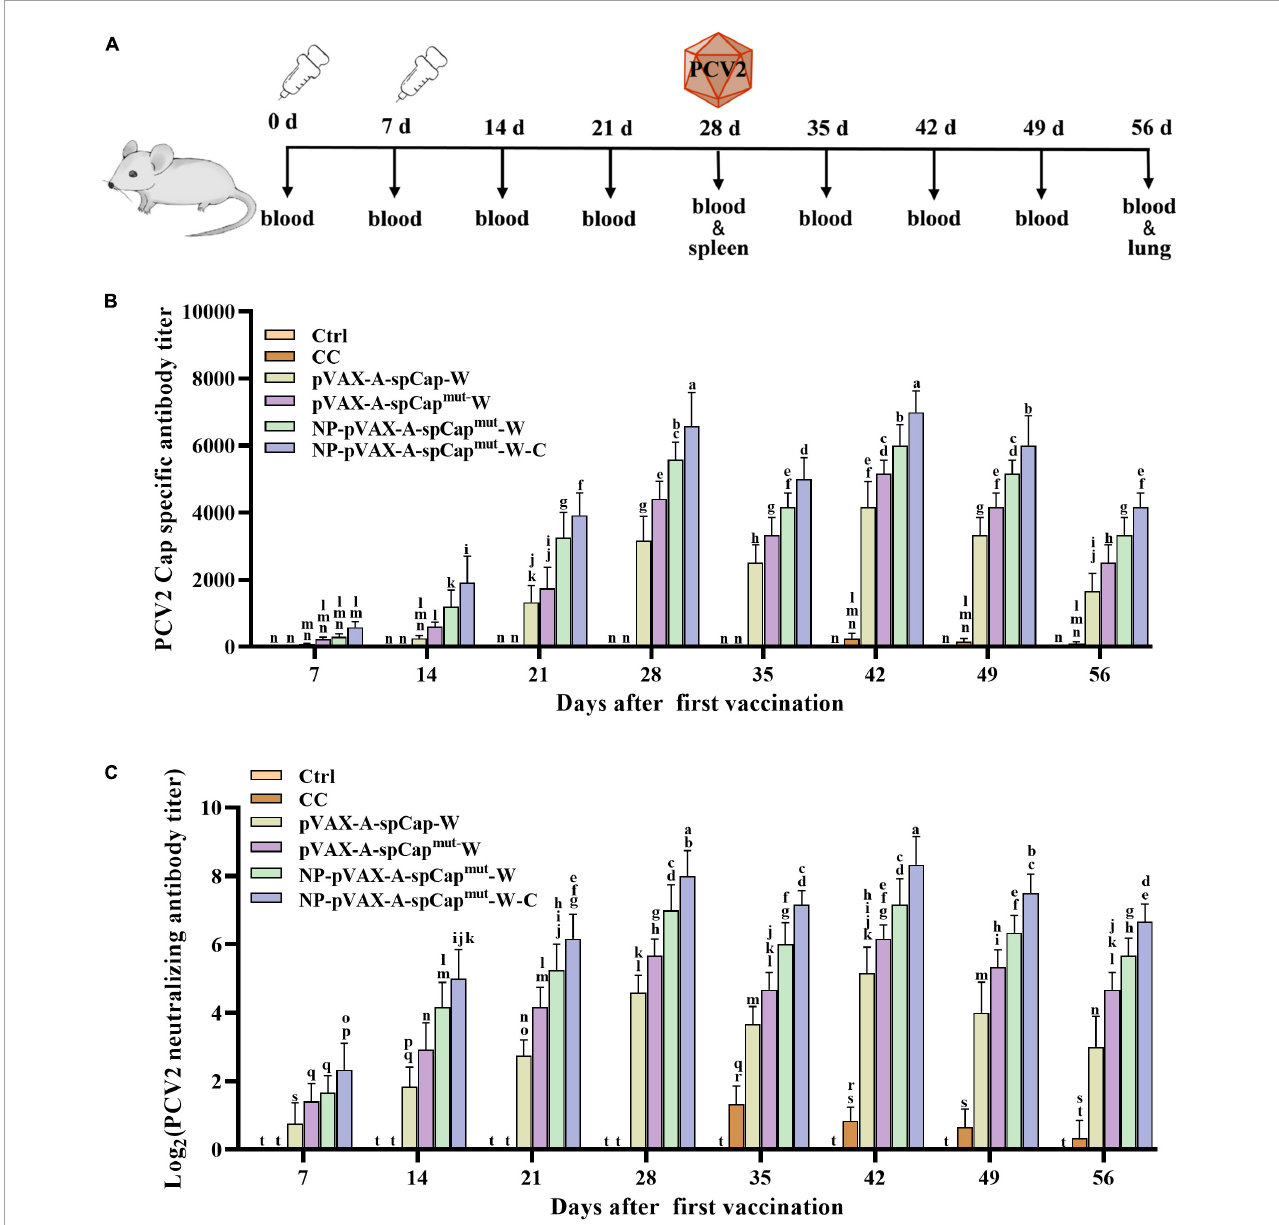
FIGURE2 The gC1qR binding site mutation Cap induces higher humoral immune response than the wild-type Cap in mice. (A) Vaccination schedule and blood collection, spleen collection, lung collection, and challenge times. (B) The serum samples of the vaccinated mice were assayed for porcine circovirus type 2 (PCV2) Cap-specific antibody levels by enzyme-linked immunosorbent assay (ELISA). (C) PCV2 were incubated with the serum samples of the vaccinated mice, and then infected to PK-15 cells for 72 h. The PCV2 levels were detected, and the PCV2 neutralizing antibody levels were calculated. The same small letters (a ∼ n) represent no significant difference among the groups, and different small letters represent significant differences among the groups in (B,C)